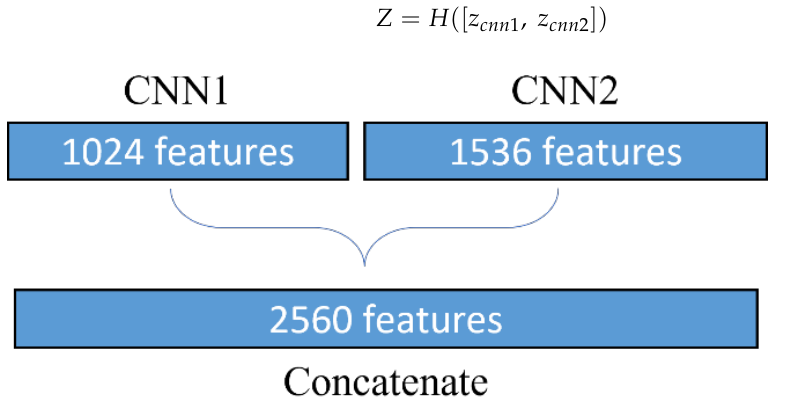
Figure 9. Illustration of concatenating features.